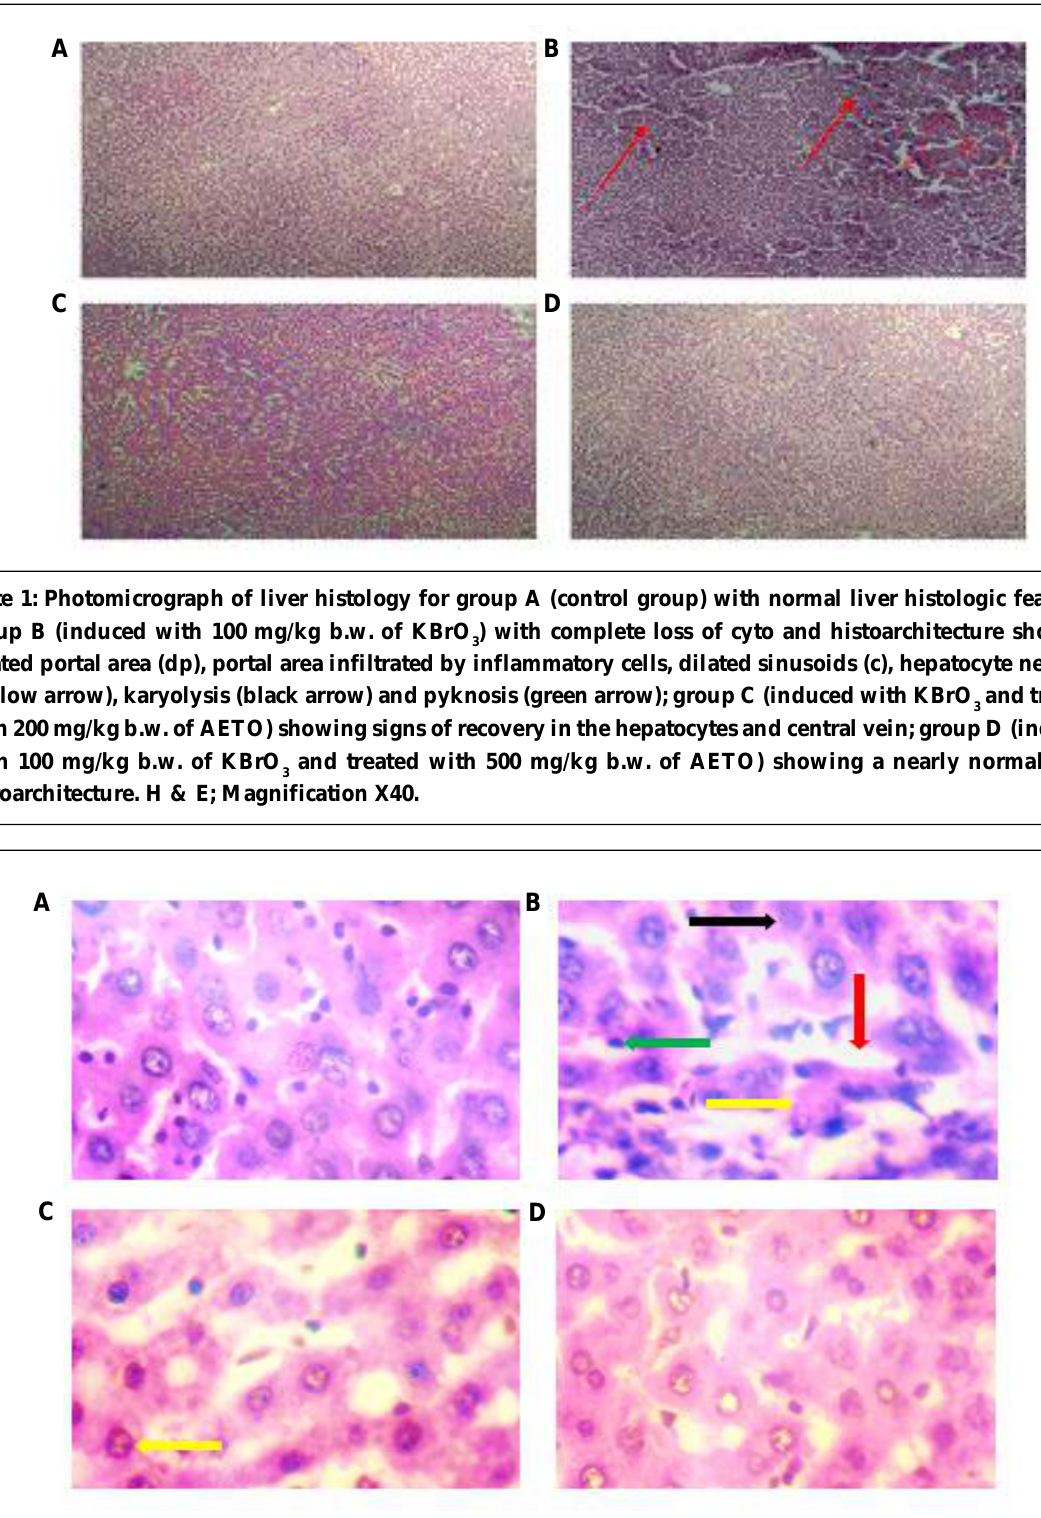
Plate 2: Photomicrograph of liver histology for group A (control group) with normal liver histologic features; group B (induced with 100 mg/kg b.w. of KBrO ) with loss of cyto and histoarchitecture showing dilated portal 3 area (dp), portal area infiltrated by inflammatory cells, dilated sinusoids (red arrow), hepatocyte necrosis (yellow arrow), karyolysis (black arrow) and pyknosis (green arrow); group C (induced with KBrO and treated with 200 3 mg/kg b.w. of AETO) showing signs of recovery in the hepatocytes and central vein; group D (induced with 100 mg/kg b.w. of KBrO and treated with 500 mg/kg b.w. of AETO) showing a nearly normal liver histoarchitecture. 3 H & E; Magnification